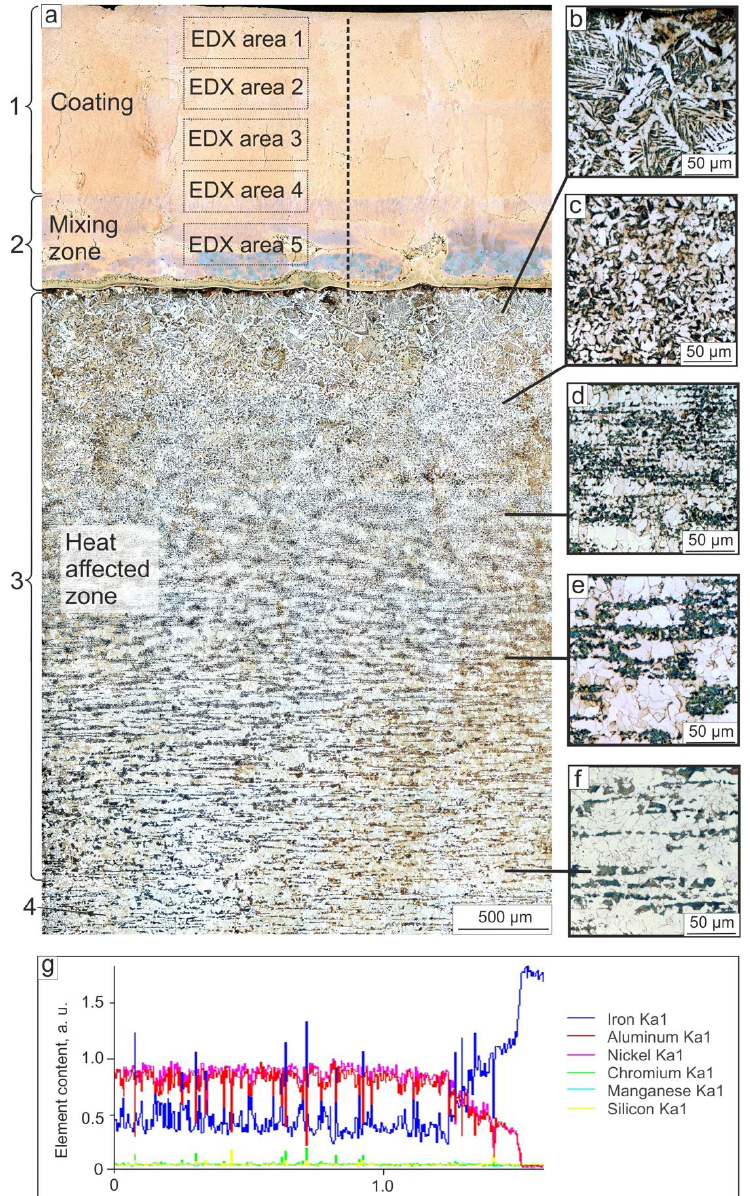
Figure 3. ( a ) Cross-section of NiAl-based coating obtained by non-vacuum electron beam cladding; ( b – e ) structures of HAZ; ( f ) initial structure of the low-carbon steel substrate; ( g ) the concentration of elements in the coating along the dotted line in Figure ( a ) were measured by EDX. According to the XRD study, the coating consisted solely of the NiAl-based phase (Figure 4). However, EDX analysis showed that the main part of the coating material contained about 14 at. % Fe, which appeared due to the partial melting of the steel sub-